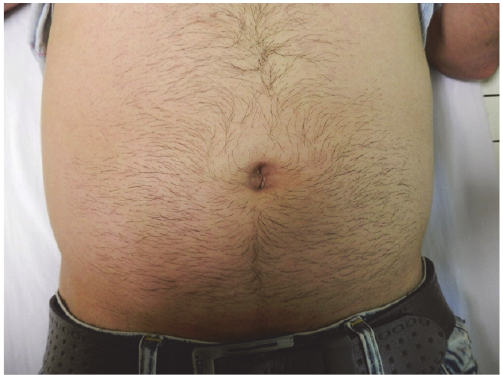
Table 1: Summary of reported cases of eccrine nevus in literature.